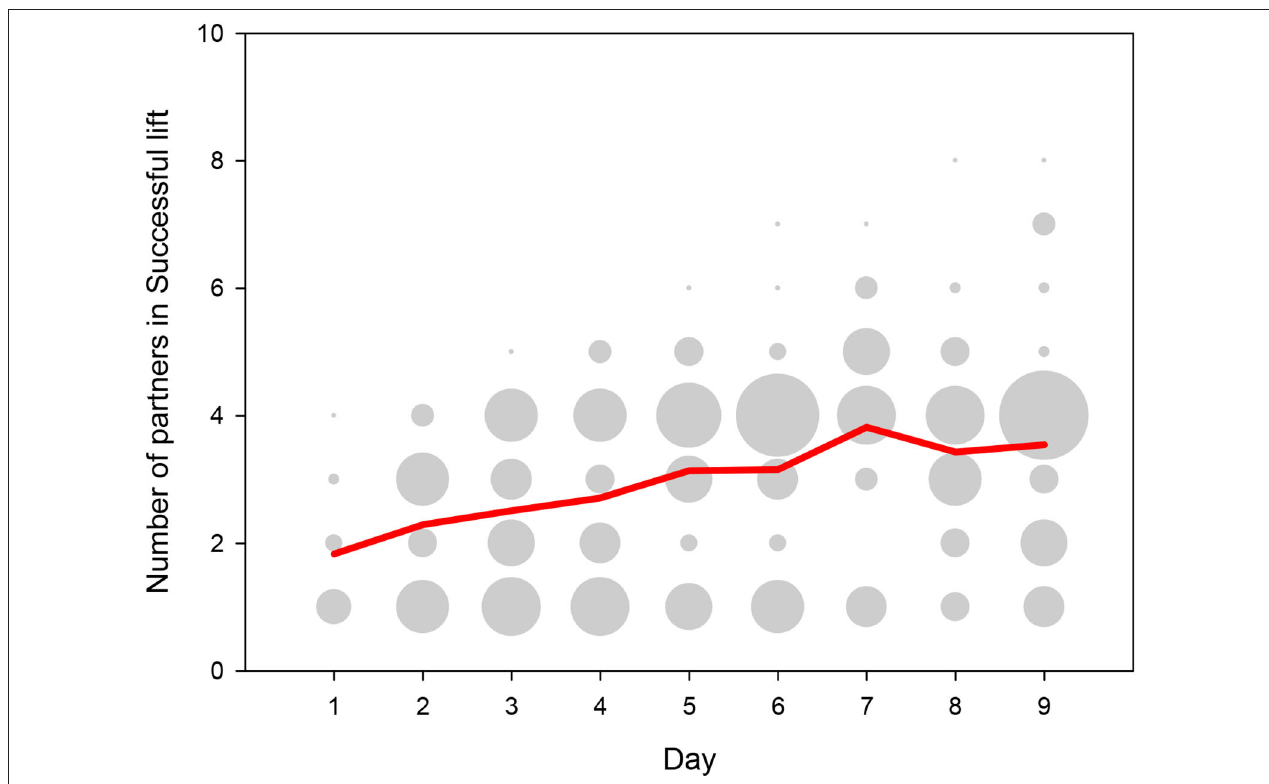
FIGURE 6 | Number of partners with whom a pig successfully lifted the log, depicted for those pigs that lifted the log at least once on a given day. The y-axis shows the number of partners per test day for a given pig whereby the dot size depicts the number of pigs that lifted for that specific number of partners. The red line depicts the mean number of partners across